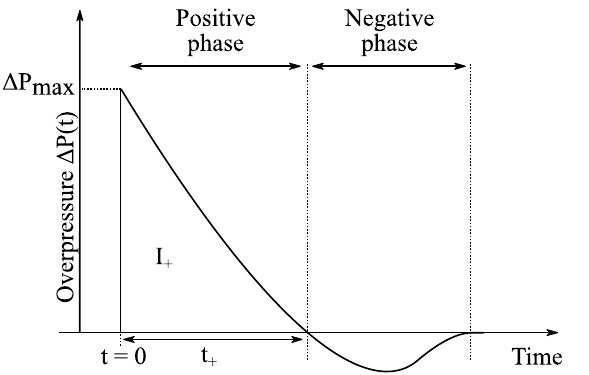
Figure 1. Typical variation in the overpressure at the front of a blast wave generated by the explo- sion of a load. of a